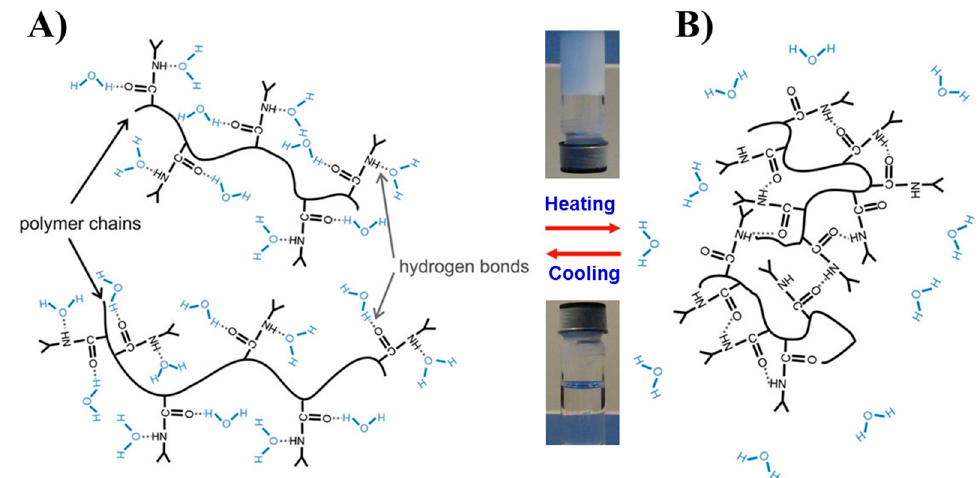
Figure 3. Representation of ( A ) the swollen PNIPAAm hydrosol in aqueous solution below T c (32 °C) and ( B ) the shrunken dehydrated PNIPAAm hydrogel above T c (32 °C). Adapted with permission from Reference [64]. Copyright © 2015 Springer Science & Business Media Singapore.